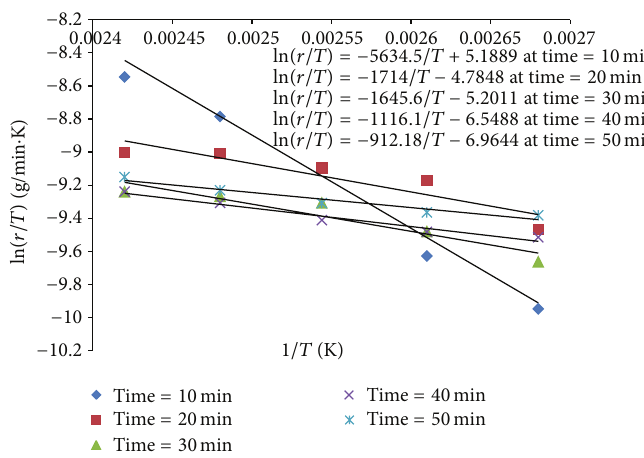
Figure 4: ln (𝑟/𝑇) versus (1/𝑇) of PVC resin at different time (min.) and at different temperature (100–140 ∘